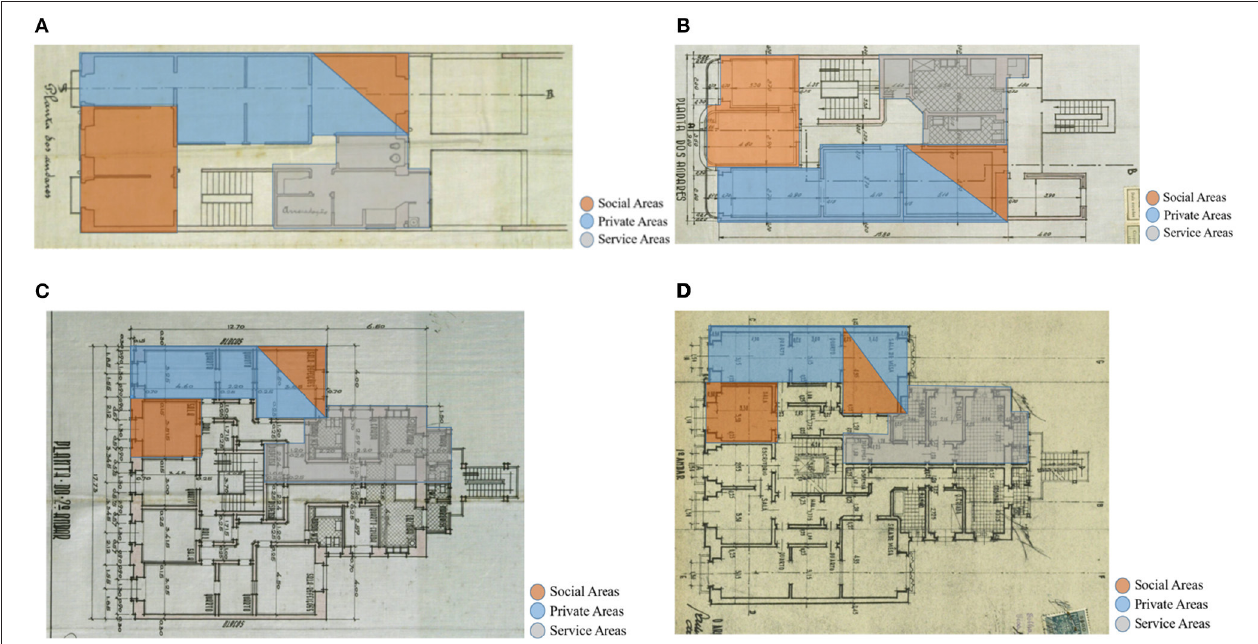
FIGURE 1 | An evolution of the shape of the buildings plan through the years. (A) Building plan with masonry/timber structure (1907). (B) Building with similar plan but with masonry RC structure (1937). (C) Building plan “rabo de bacalhau” with masonry/timber RC concrete (1944). (D) Building with similar plan “rabo de bacalhau” but with masonry RC